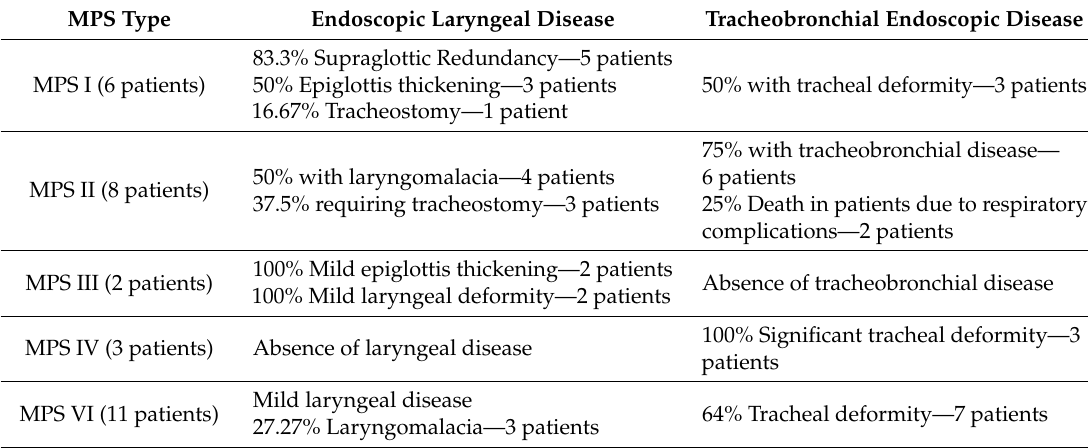
Table 2. Summary of the main endoscopic findings of laryngotracheobronchial disease according to MPS type.